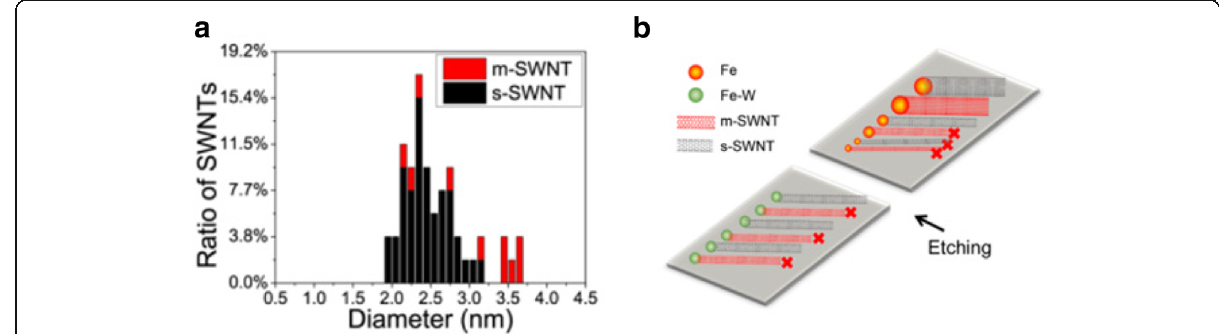
Fig. 13 a Diameter and chirality distributions of the FeW-catalysed SWCNTs under a water vapor concentration of 522 ppm. About 90% of the as- prepared SWCNTs were reported to be in the diameter range of 2.0 – 3.2 nm adapted from [140]. b Schematic illustration of the diameter-dependent and electronic-type-dependent etching mechanisms during growth. High selectivity of s-SWNTs could be obtained by controlling the diameter via the Fe-W catalysts. Adapted from